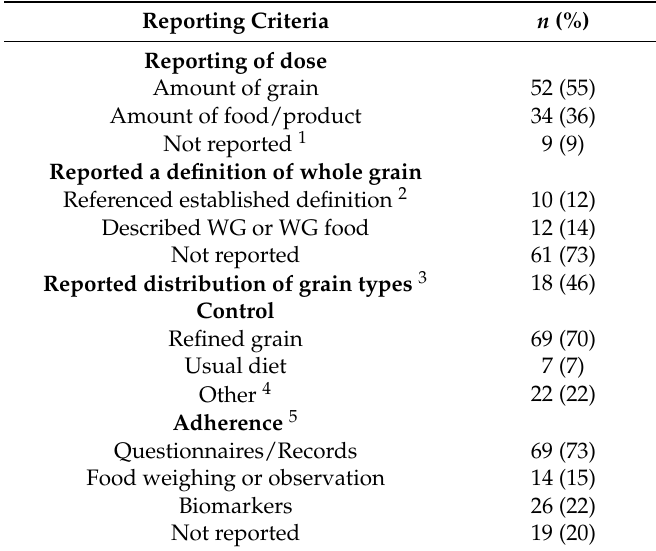
Table 2. Reporting practice in moderate (>1 day to 6 weeks) and long (>6 weeks) duration whole grain intervention trials in